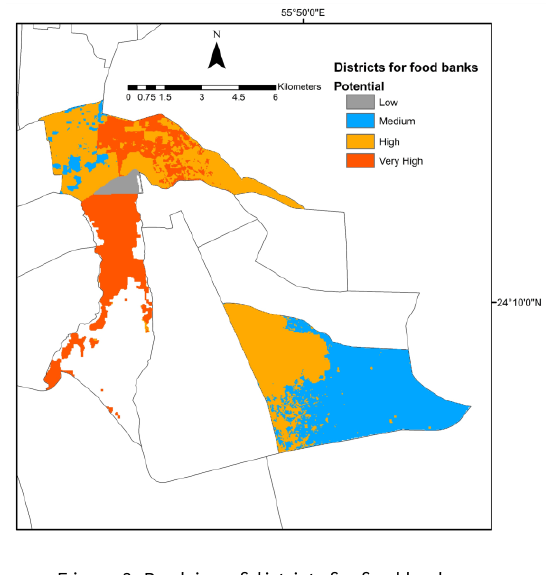
Figure 3. Ranking of districts for food bank locations.